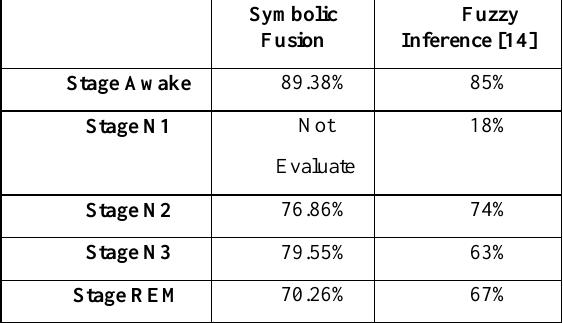
Table 1. Agreement Rate comparison between symbolic